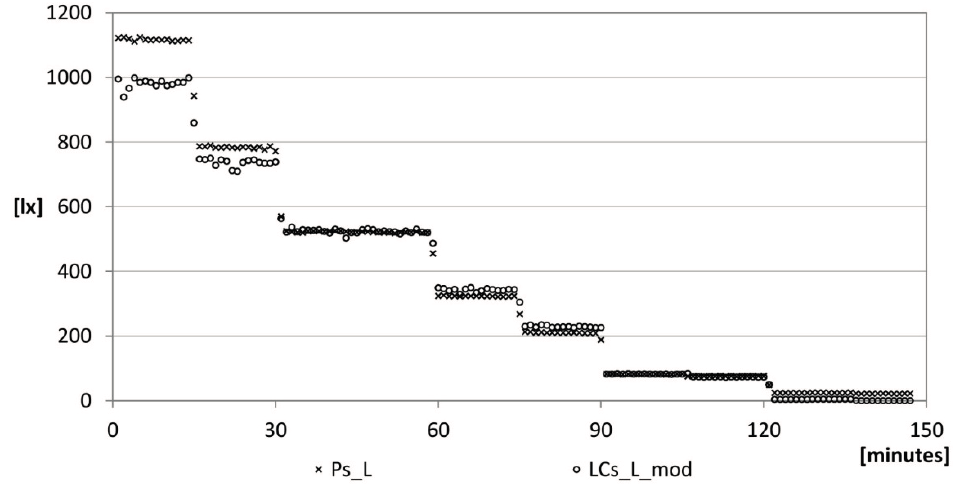
Figure 12. Lighting: correction